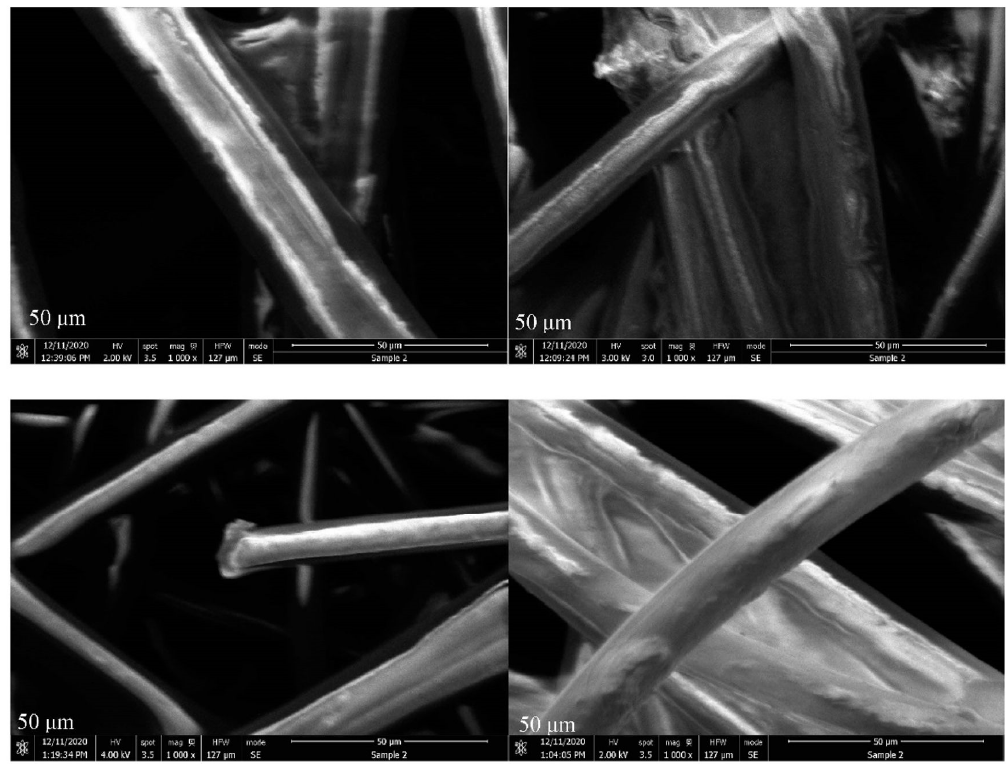
Figure 6. SEM images of ACL at 1000× magnification.